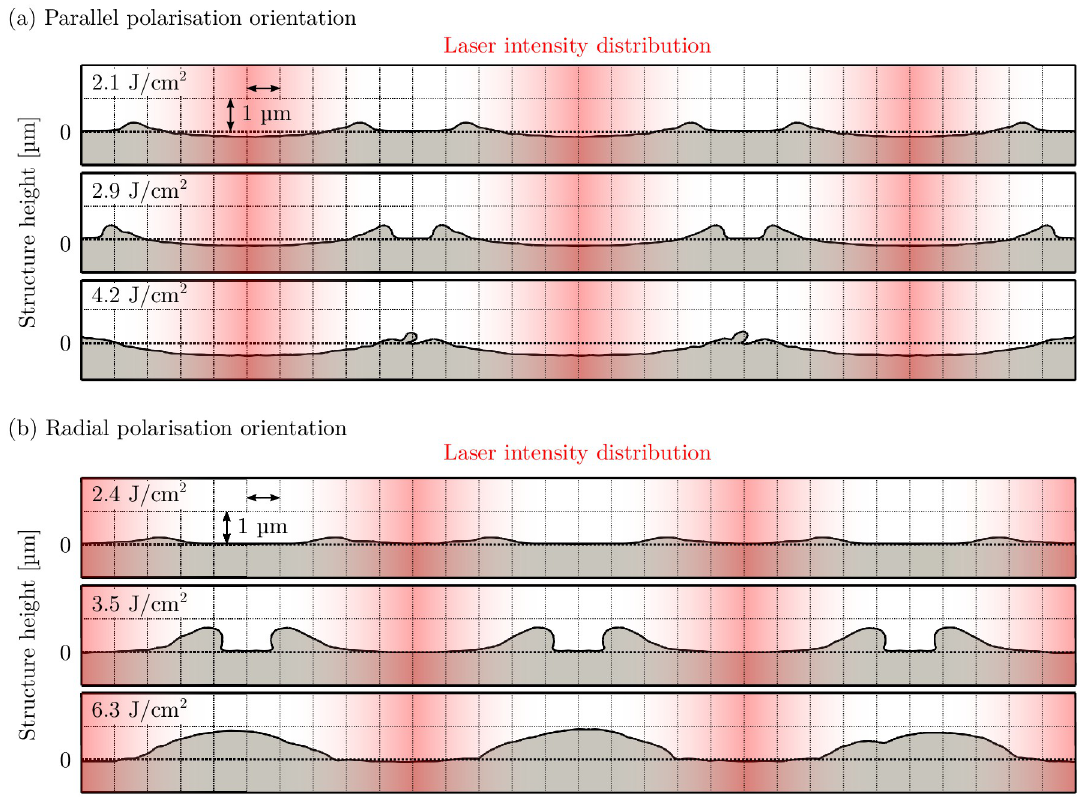
Fig 7. Simulated formation of solidified surface structures for (a) parallel polarization orientation, and (b) radial polarization orientation. The laser intensity distribution is indicated by the red shaded area.